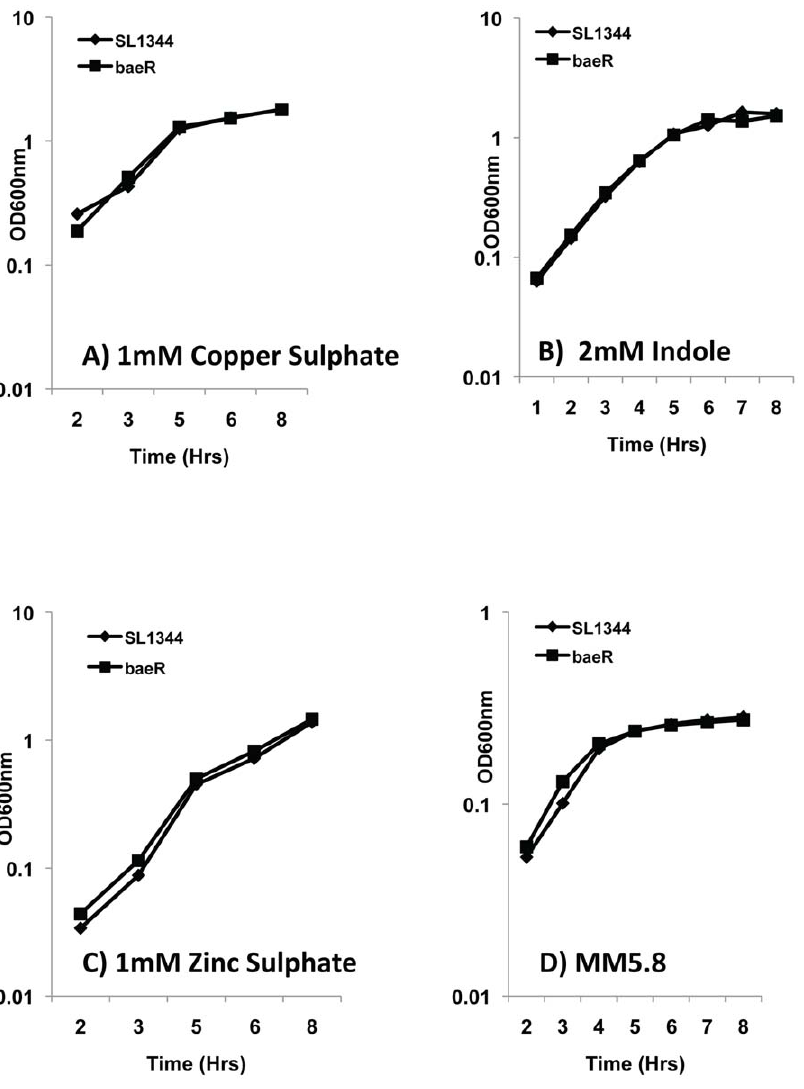
Figure 2.Growth curves of Salmonella Typhimurium SL1344 wild type and baeR mutant. LB media was supplemented with 1mM Copper Sulphate (A), 2mM Indole (B) and 1mM Zinc Sulphate (C). In panel (D), the cells were grown in Minimal Media pH5.8 to mimic intra-macrophages conditions. The growth of the baeR mutant was not significantly different from the wild type in either of those conditions.